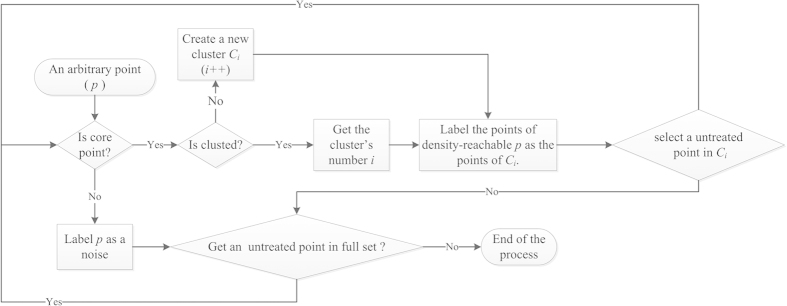
Flow chart for MA.